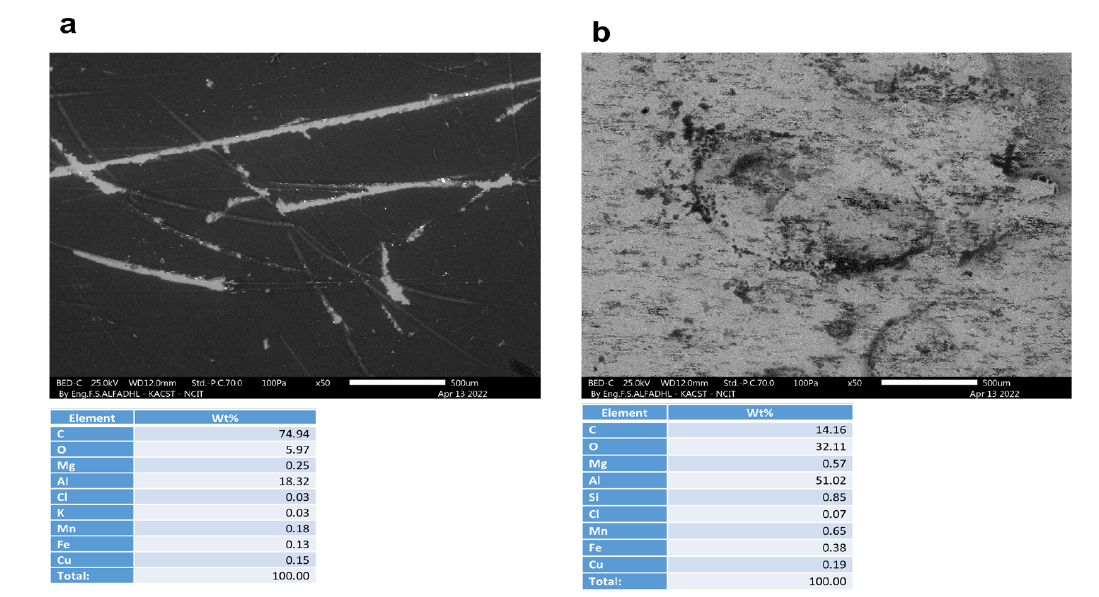
Figure 12. SEM and EDS analysis of Red Bull samples after corrosion tests under different conditions: ( a ) main solution in the presence of an organic coating (WC) and ( b ) without an organic coating (WOC).